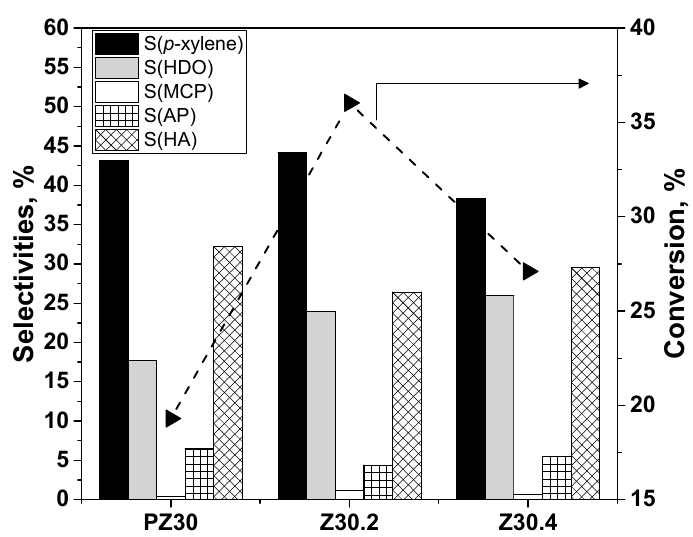
Figure 7. Conversion and selectivities to known products as a function of time for the Diels–Alder cycloaddition of 2,5-dimethylfuran (DMF) and ethylene over H-ZSM-5 (30). Reaction conditions: temperature, 250 °C; pressure, 55 bar; catalyst, 120 mg; 30 mL of 3 M DMF in n -octane; and stirring, 1100 rpm. Mass balance increased from 66% at first sampling to 73% at the end of the reaction.